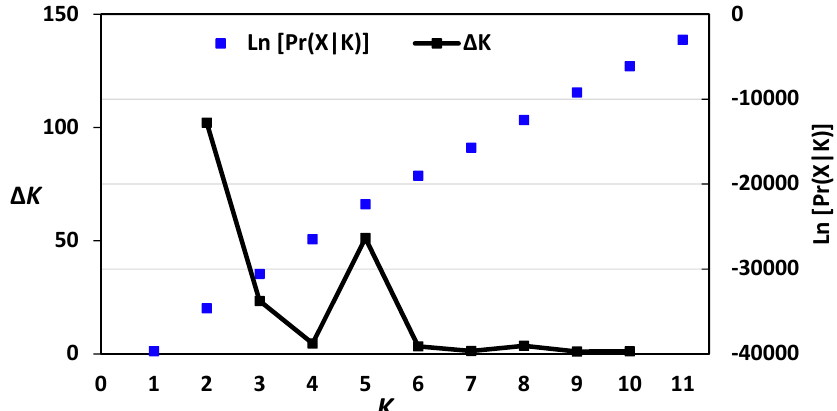
Figure 2. Log-likelihood and Δ K values of structure analysis of the 40 barley accessions based on AFLP data. K = 2 had the highest Δ K value, indicating that the 40 barely accessions could be assigned to two populations.